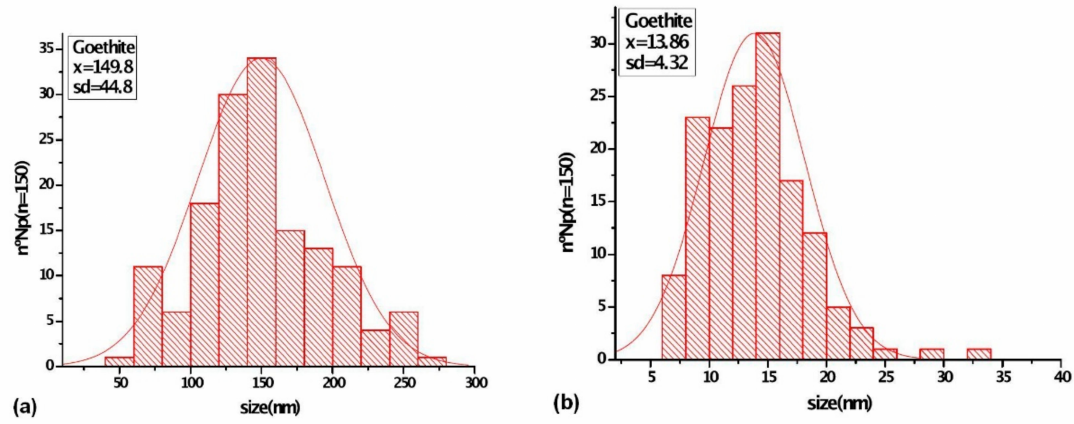
Figure 3. Histogram of the goethite nanorods size distribution based on n = 150 nanoparticles evaluated. ( a ) NP length distribution; ( b ) NP width distribution.